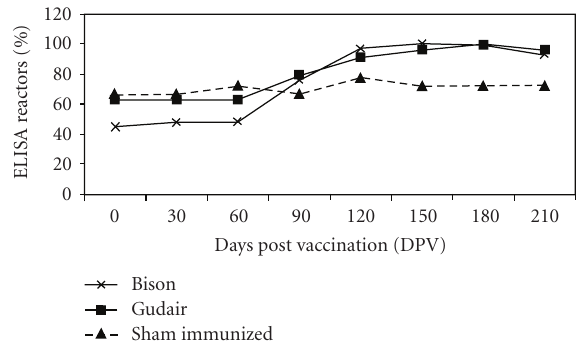
Figure 4: Percent ELISA reactors at di ff erent time intervals (days post